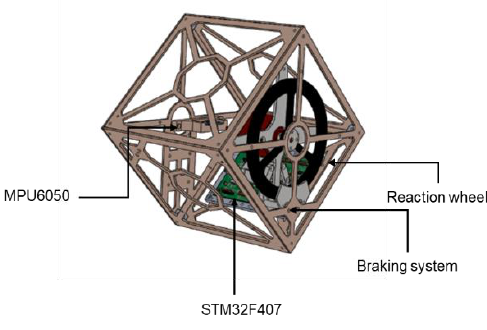
Figure 2. The cube robot prototype.